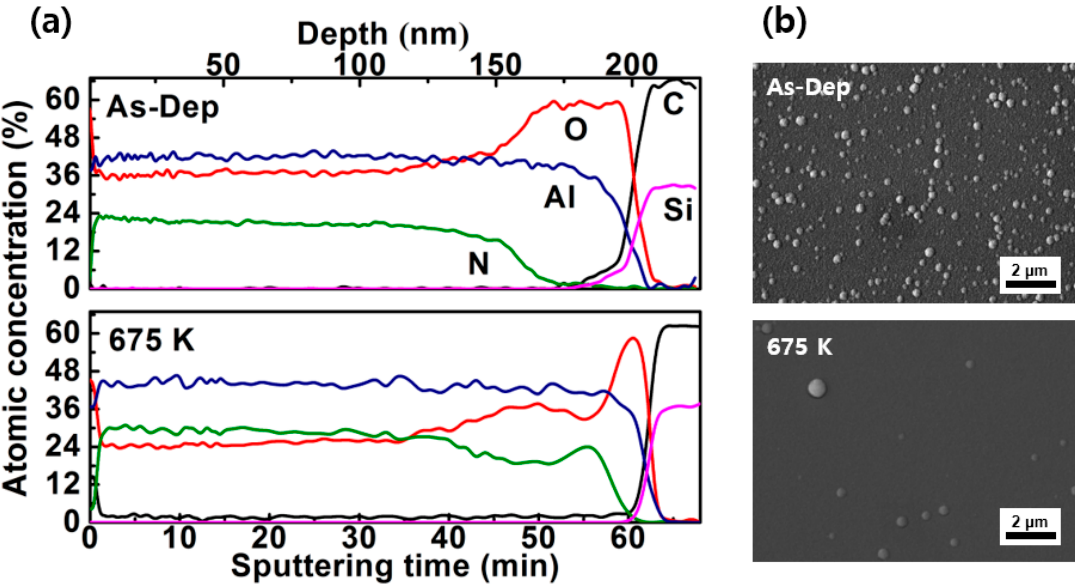
Figure 5. ( a ) Auger Electron Spectroscopy (AES) concentration profile ( b ) SEM images of fabricated AlN /4H-SiC.